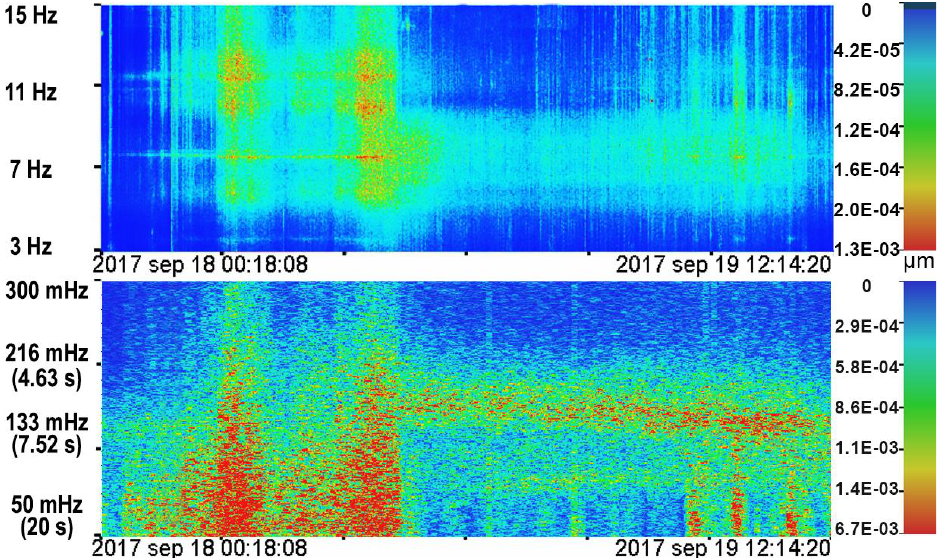
Figure 15. Dynamic spectrogram of laser strainmeter data during influence of Talim